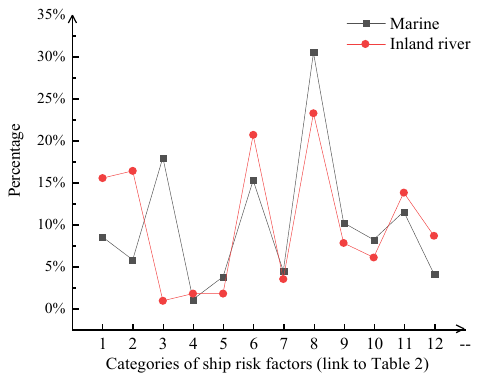
Figure 6. Proportion of Sub-Factors of Marine and Inland River Human Factors.